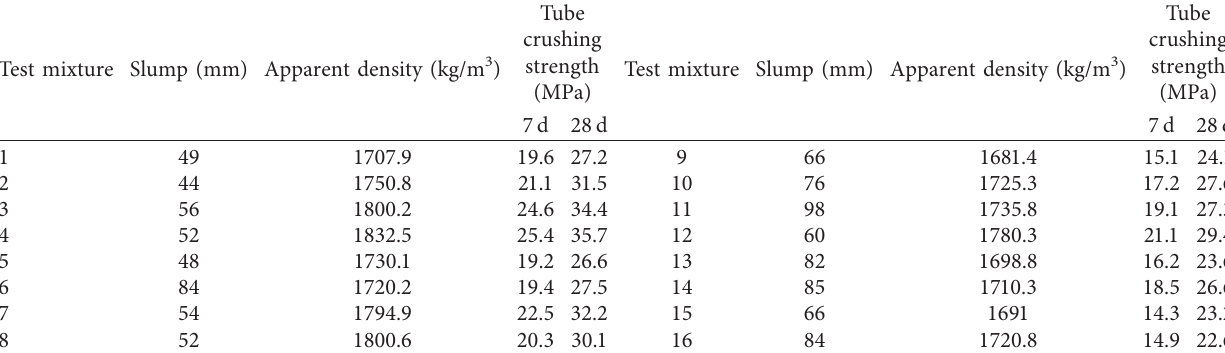
Table 9: Test results for mixture ratio.